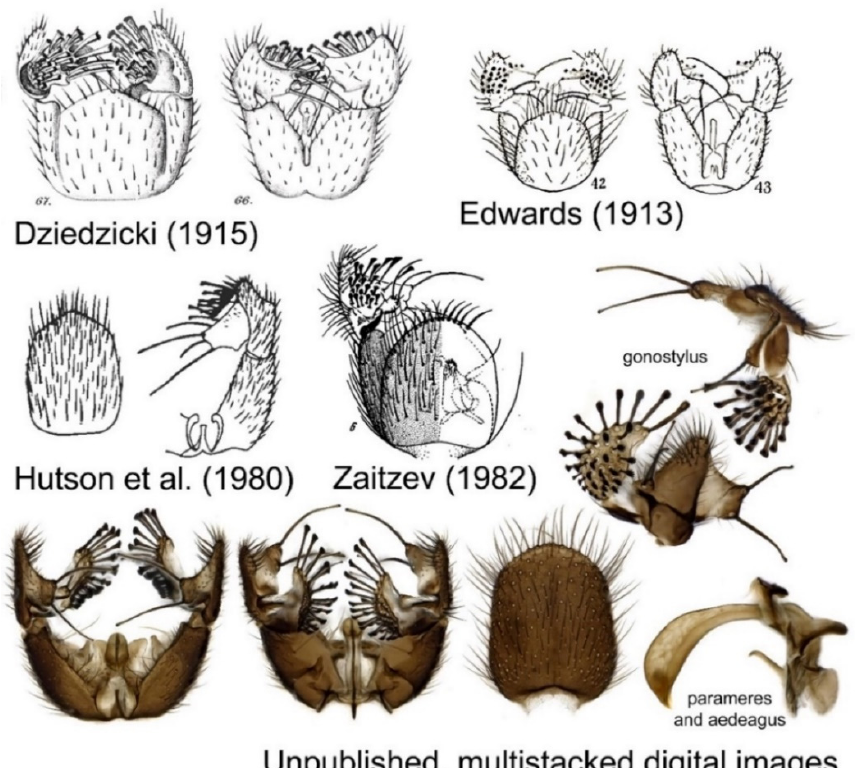
Figure 2. Example of historic illustrations over the last century for illustrating species-specific characters of the male terminalia for the fungus gnat species Sciophila hirta (Meigen 1818). The species’ terminalia has been illustrated by Edwards, Dziedzicki, Hutson et al. and Zaitzev [7–10]. Today, stacked digital images replace illustrations where more details and angles of their complex three-dimensional structures can be depicted with less work. By aid of DNA barcoding, this species is now about to be split into a complex of several semi-cryptic species that can only be safely separated based on details in their internal organs such as parameres and aedeagus, as such largely invalidating usage of previously published illustrations.